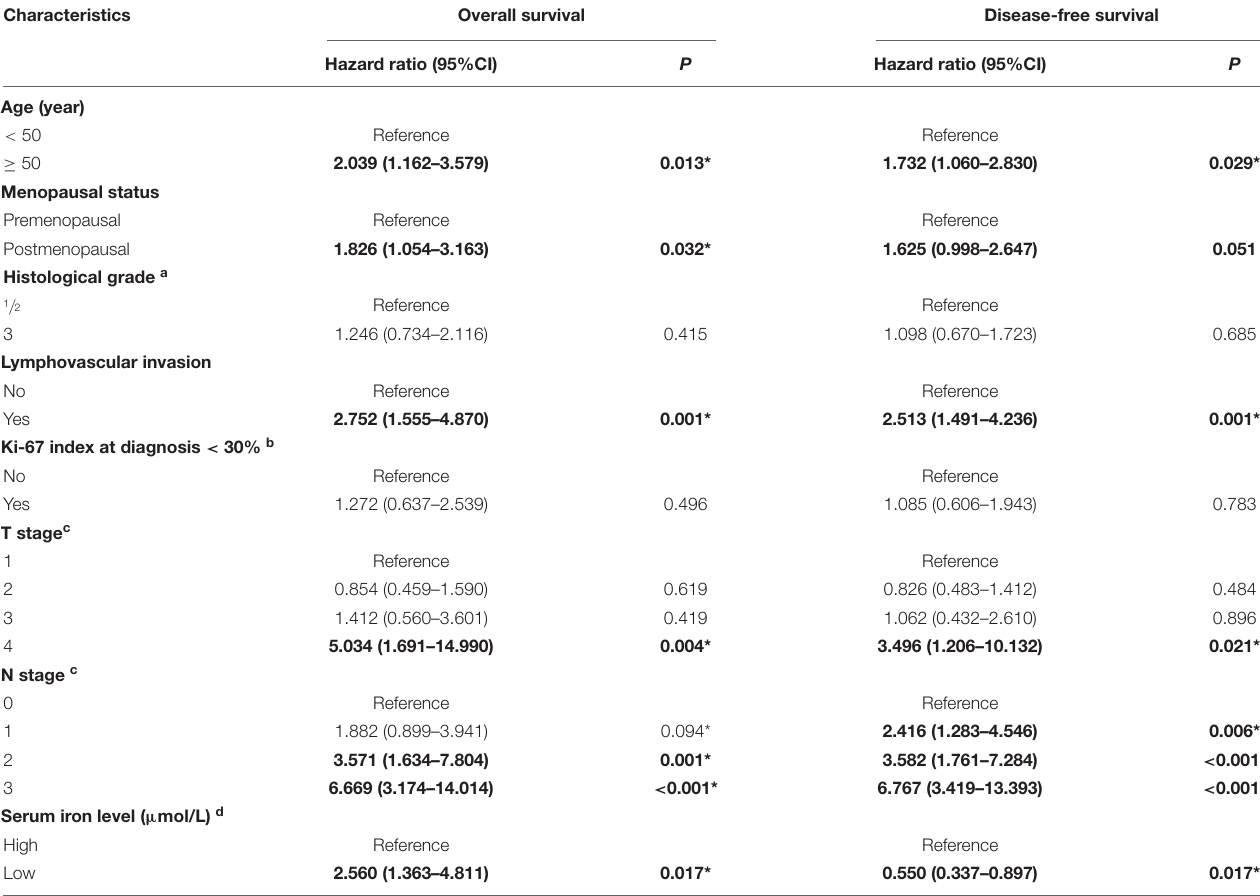
TABLE 2 | Univariate Cox regression analysis of overall survival and disease-free survival in women with breast cancer in the training cohort.